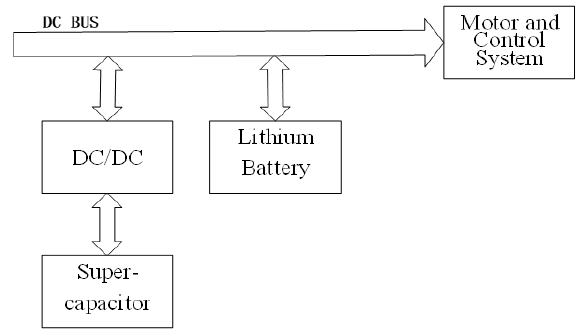
Figure 1. Electric vehicle hybrid system.